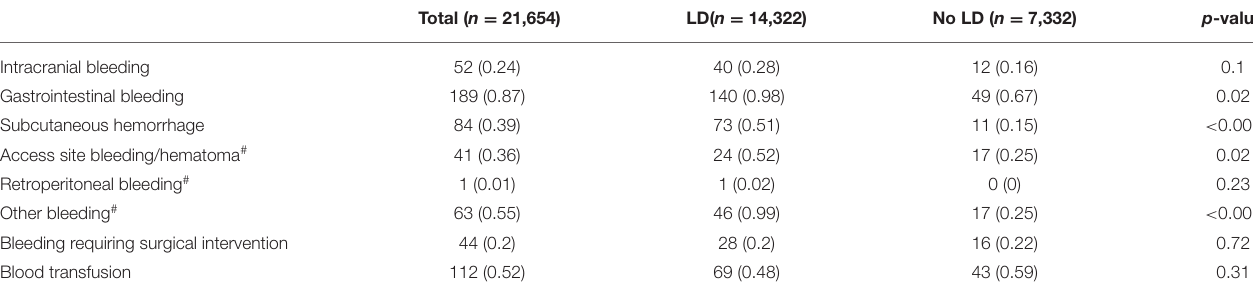
TABLE 3 | Location and intervention of bleeding.